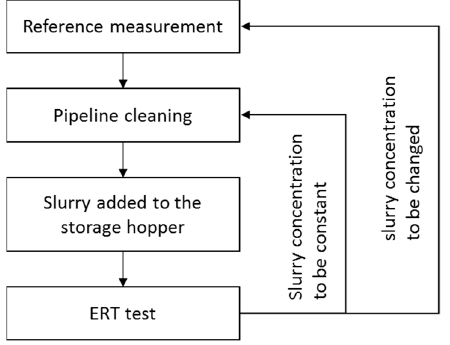
Figure 6. Operation procedure of pipeline transport experiment using ERT.